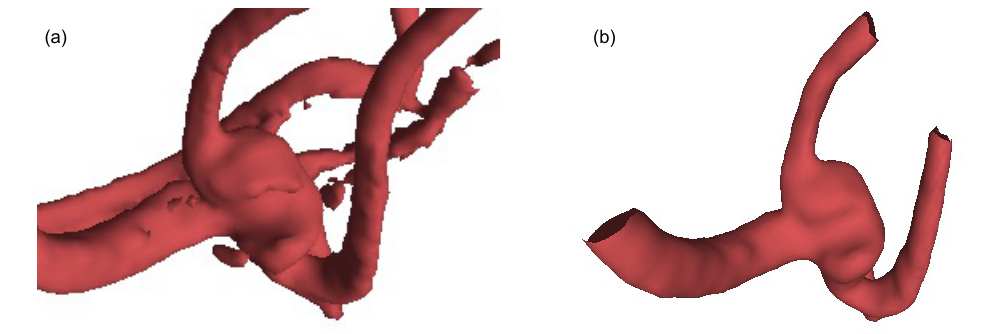
Figure 4. Comparison of IntrA data before and after manually refined: ( a ) The coarse surface before manually refined, ( b ) The smooth surface after manually